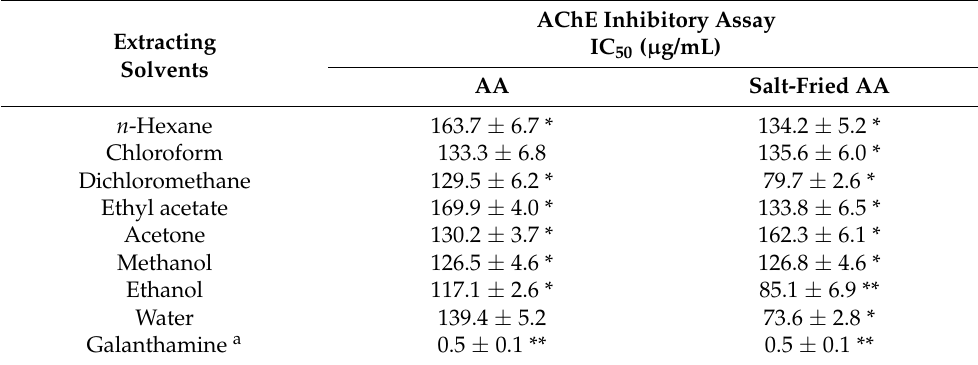
Table 4. AChE inhibitory assay of different solvent